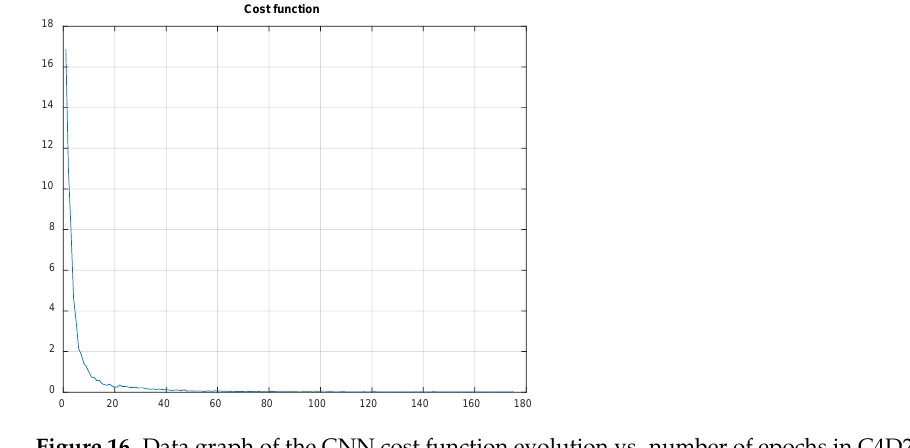
15 of 18 Figure 15. Training QR code realization of subject 1 at trial 1 for 4 classes: left, right, feet, and tongue (18 × 16) in C4D2a_4C.